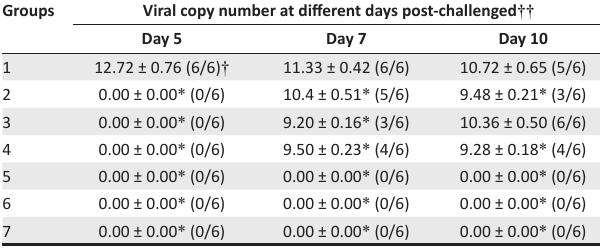
TABLE 4: Cloacal virus shedding of specific pathogen-free chickens following challenged with genotype VII Newcastle disease virus. Groups